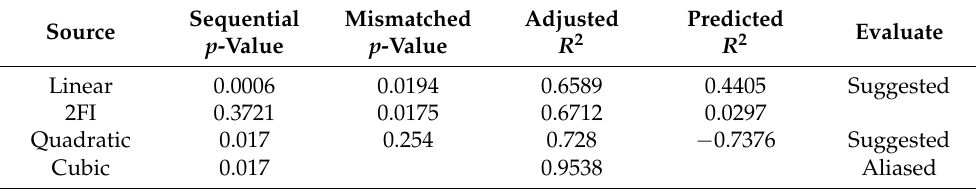
Table 8. Comprehensive analysis of various models of compressive